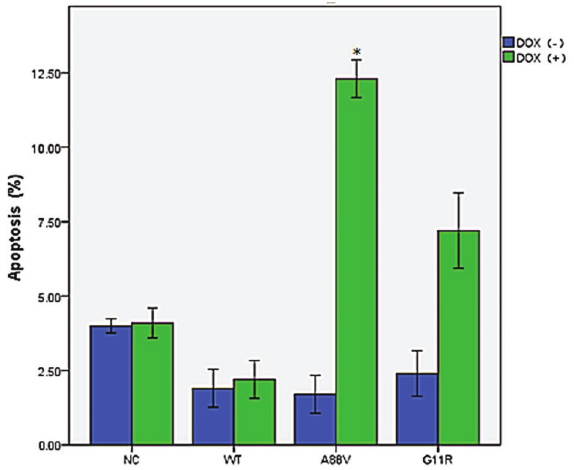
Figure 3. Flow cytometry results showing levels of apoptotic cells in negative control (NT), wild type (WT), A88V mutant, and G11R mutant cells, induced or not by doxycycline ( + DOX, and – DOX). Data are reported as means ± SD. *P o 0.05, t -test.